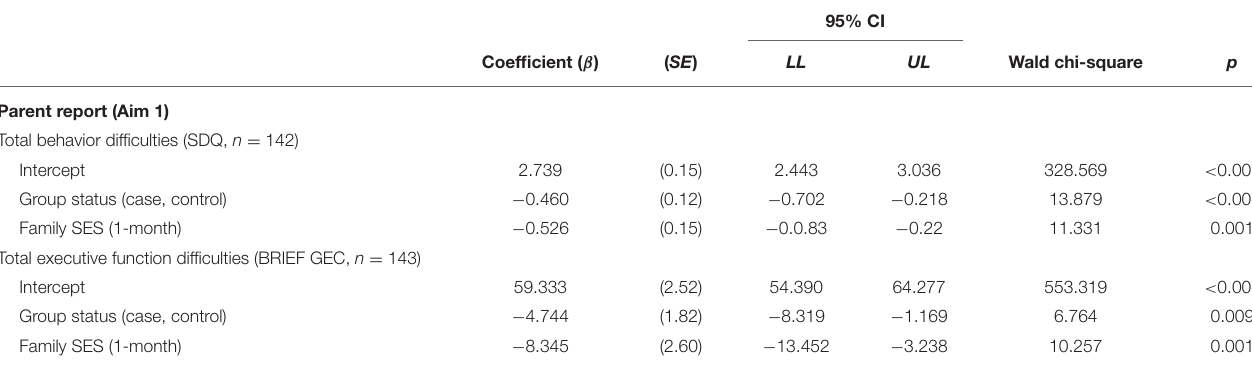
TABLE 4 | Gamma regression model results examining the roles of group status and family SES in child total outcome scores differentiating mild TBI cases and non-TBI